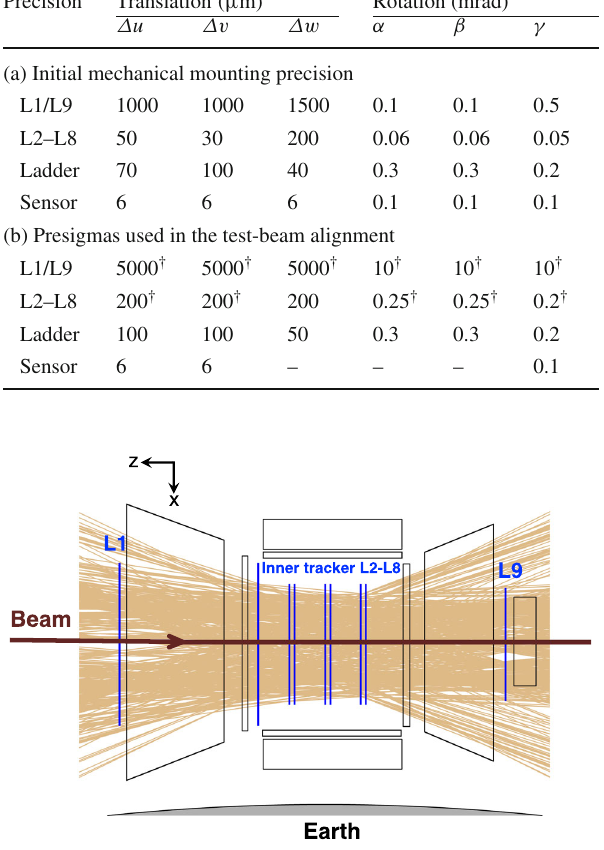
Fig. 6 Schematics of the nominal attitude of the AMS in the beam test: the z -axis of the AMS against the beam direction, the x -axis to the nadir, and the y -axis (pointing out of the page) parallel to the Earth. The densely packed lines represent the 886 directions of the primary 400 GeV/c proton test beam passing through